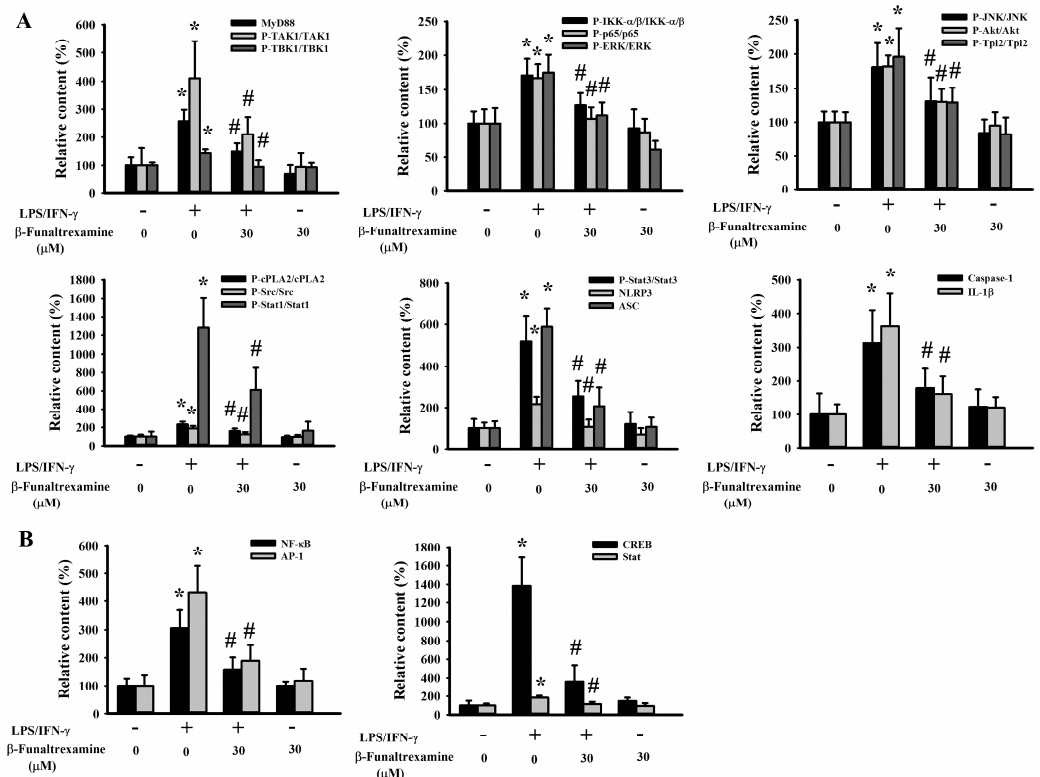
Figure 5. Quantitative data of β -funaltrexamine-alleviated intracellular signaling molecules: Neuron/glia cultures were pretreated with vehicle or β -funaltrexamine (30 μ M) for 30 min before being incubated with LPS (100 ng/mL)/IFN- γ (10 U/mL) for an additional 4 h. ( A ) Total cellular proteins were extracted and subjected to Western blot analysis with indicated antibodies. ( B ) Nuclear proteins were extracted and subjected to EMSA for the measurement of NF- κ B, AP-1, CREB, and Stat DNA binding activities. Quantitative data are shown. * p < 0.05 vs. untreated control and # p < 0.05 vs. LPS/IFN- γ control, n = 4.